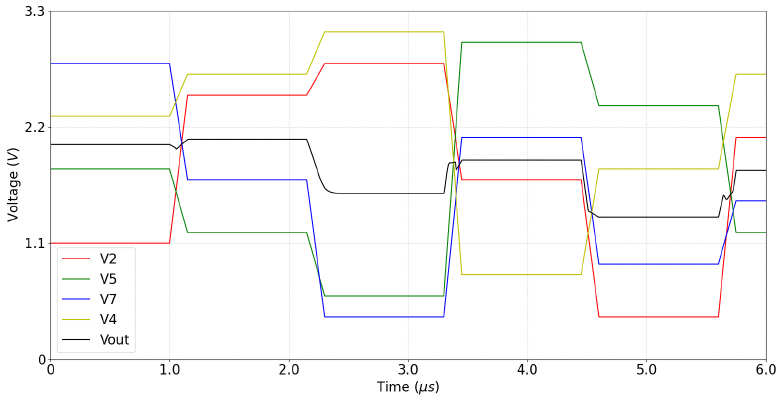
Figure 12. Post-layout simulation of the defective pixel correction